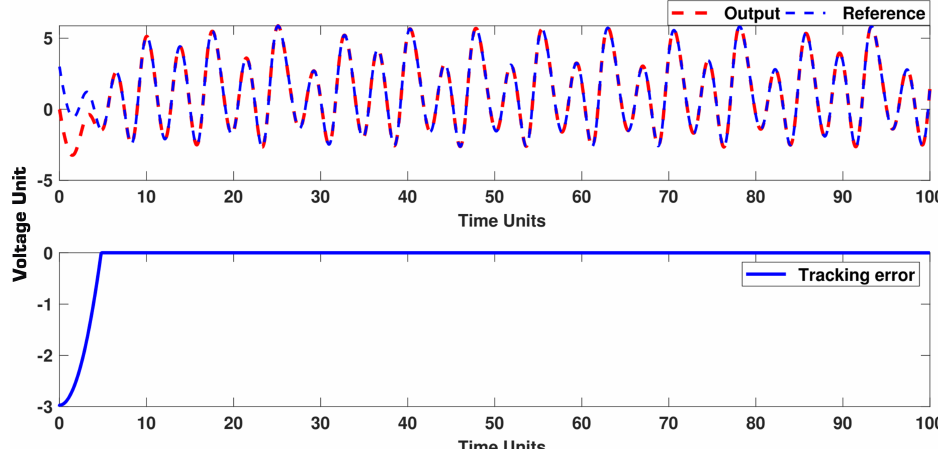
Figure 11. Example 3: Output and error signals.